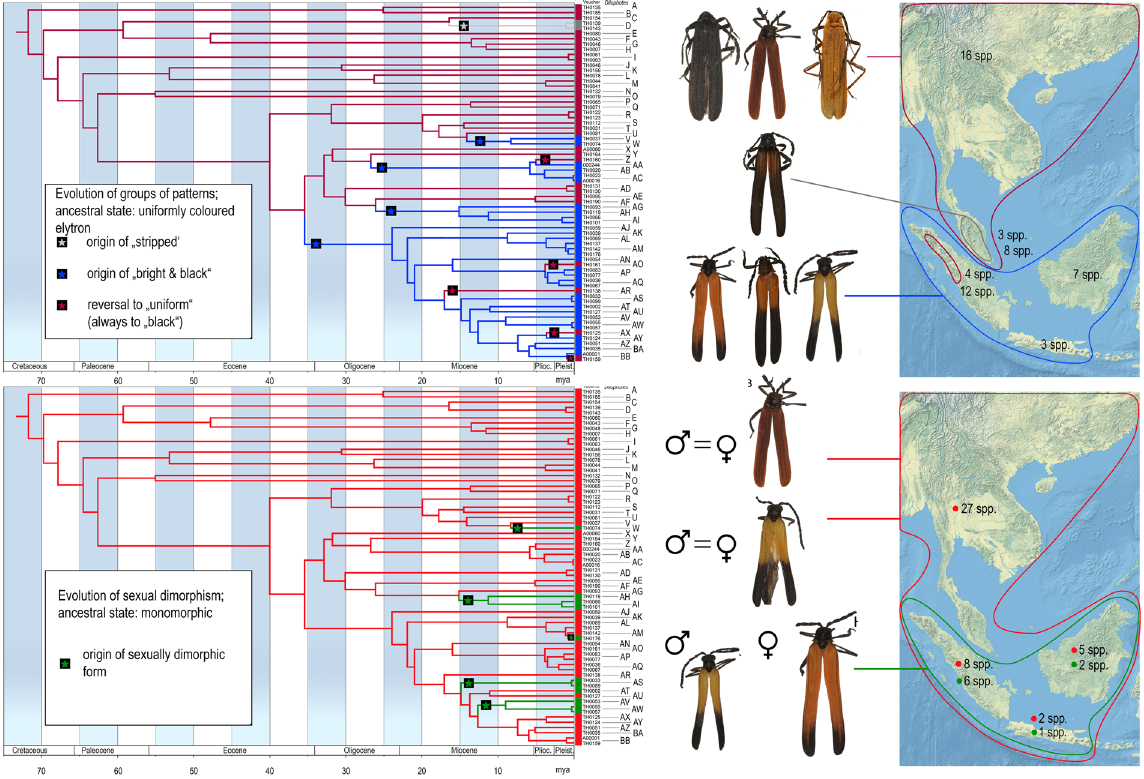
Figure 6. ( A ) Evolution of ‘uniform’ and ‘bright & black’ patterns; ( B ) Evolution of sexually dimorphic patterns. The map was downloaded from Natural Earth server (http://www.naturalearthdata.com) and edited using Adobe Photoshop CS6